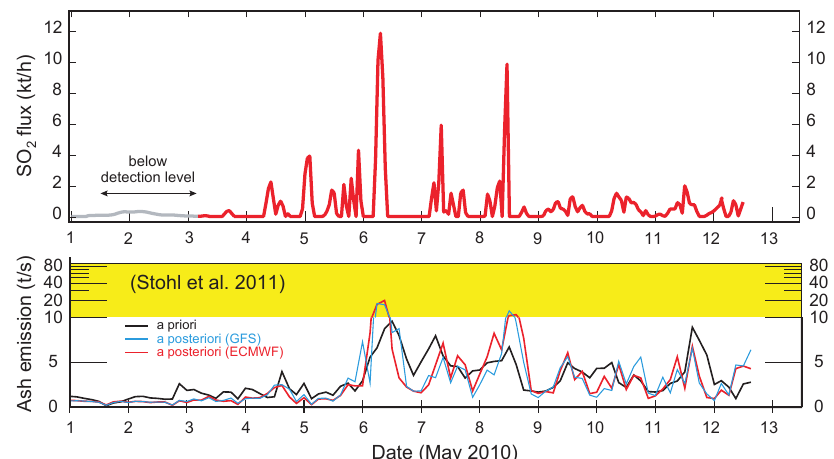
Fig. 6. Comparison between SO 2 and ash emissions during the Eyjafjallaj¨okull eruption of May 2010. (Top) Time series of the SO 2 flux (kth − 1 ) (this study). (Bottom) Ash emission rate (ts − 1 ) from the inverse modelling of Stohl et al. (2011) (The black line represents the a priori, and blue and red lines the a posteriori using respectively the GFS and ECMWF meteorological models. Note the mix of linear and logarithmic scales in the ordinate